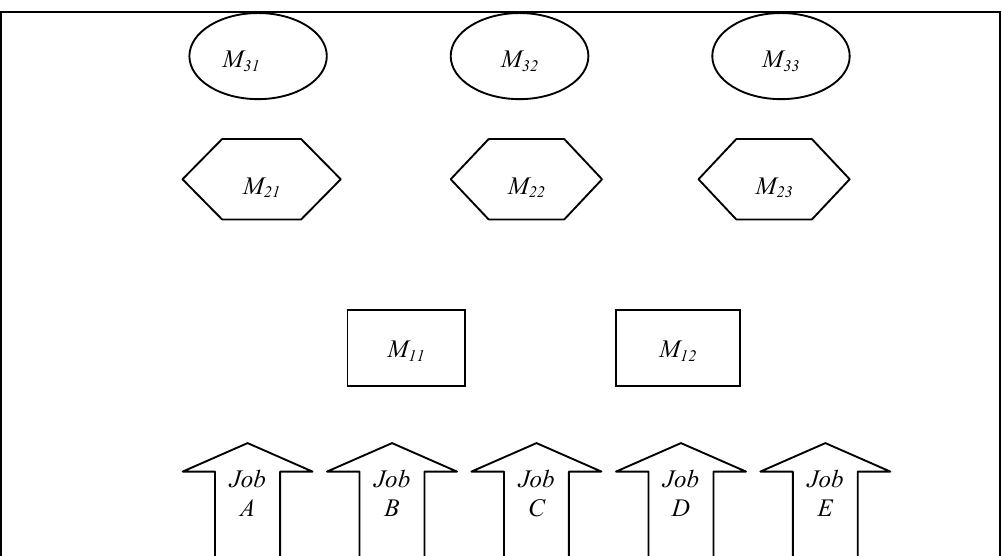
Figure 1. An Illustrative Hybrid Flow Shop Scheduling Problem